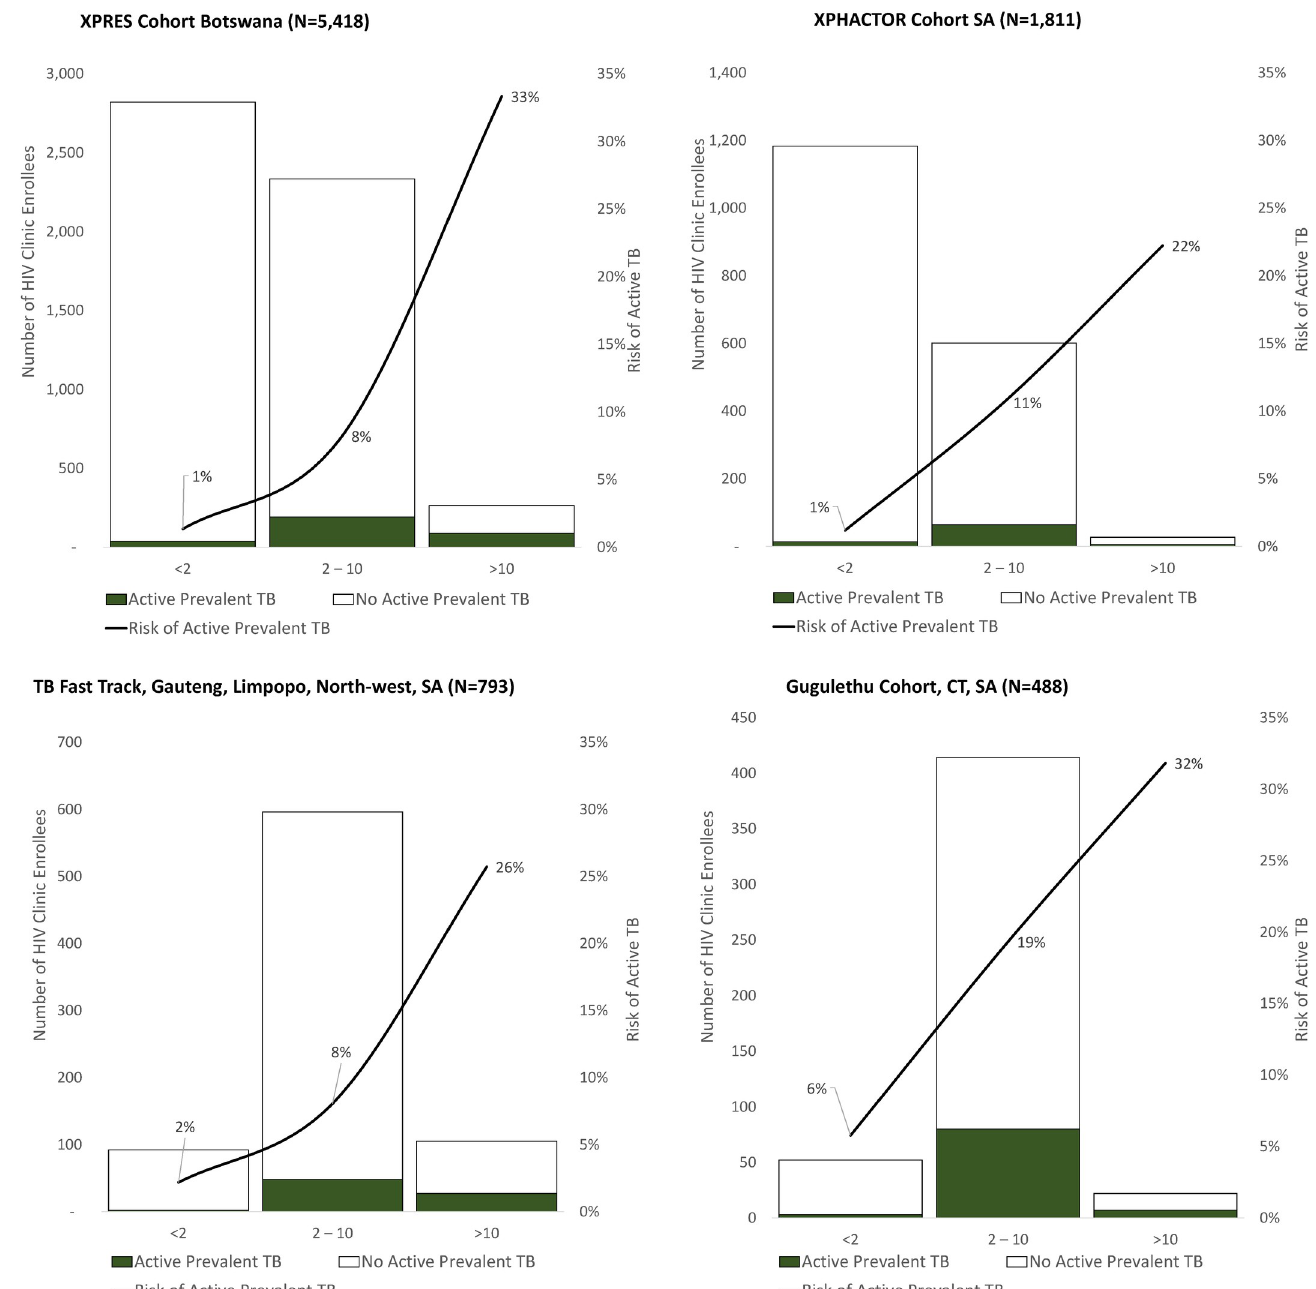
Fig 4. TB risk stratification into low-, moderate-, and high-risk groups by study cohort. CT, Cape Town; SA, South Africa; TB, tuberculosis.